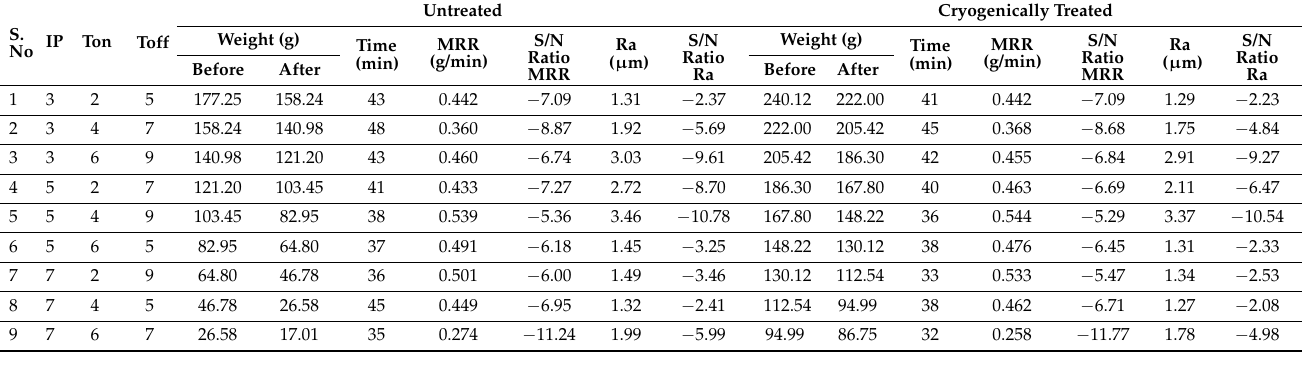
Table 2. Experimental results for the untreated and cryogenically treated electrodes and the corre- sponding S/N ratio.